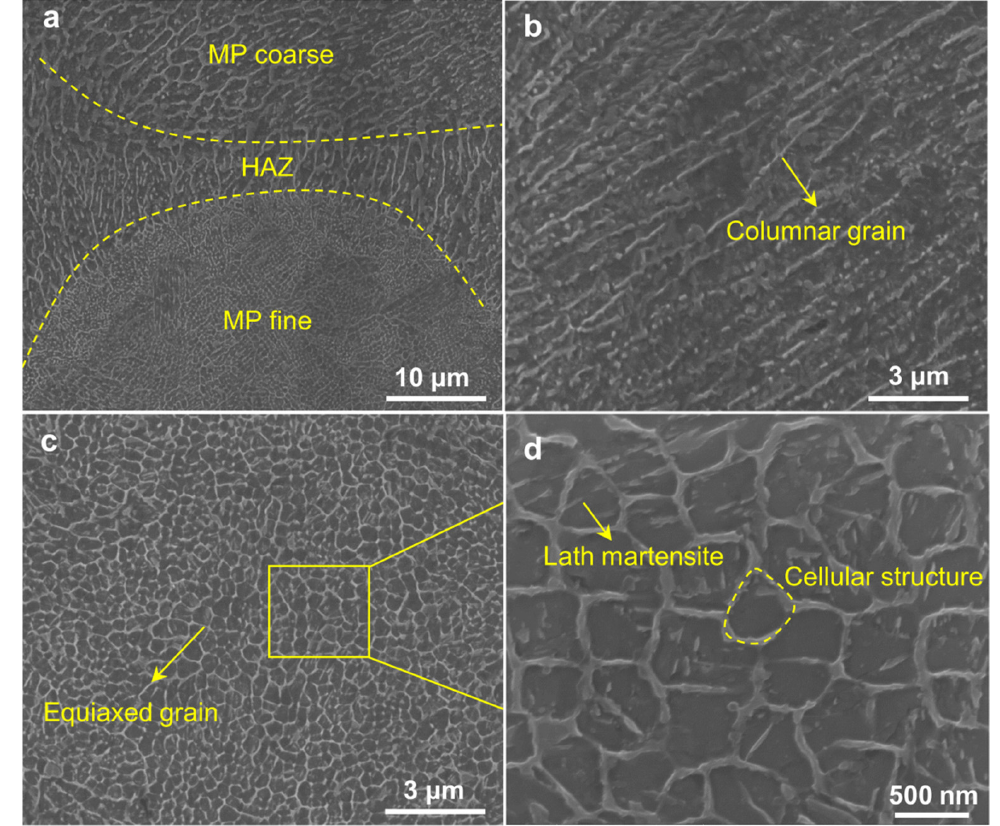
Figure 10. SEM images displaying the microstructure features of as-SLMed H13 specimens, ( a ) molten pool structure; ( b ) columnar grains; ( c ) equiaxed grains; ( d ) cellular structures and lath martensite.